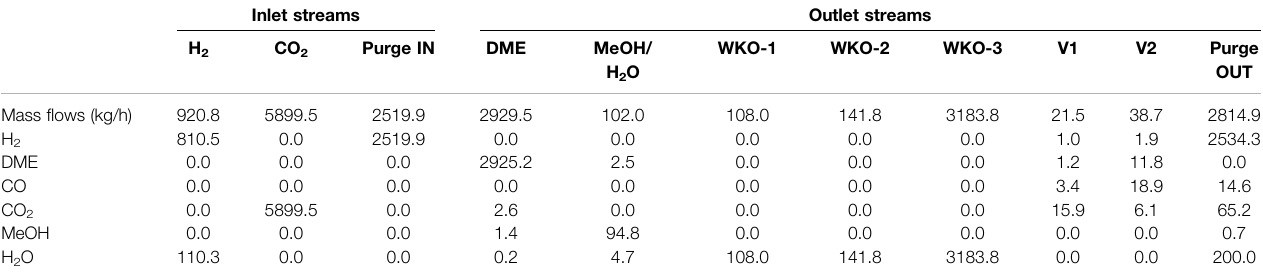
TABLE 6 | Mass fl ows and composition of the input and output streams for the power-to-X technology SEDMES process simulated using ASPEN. Inlet